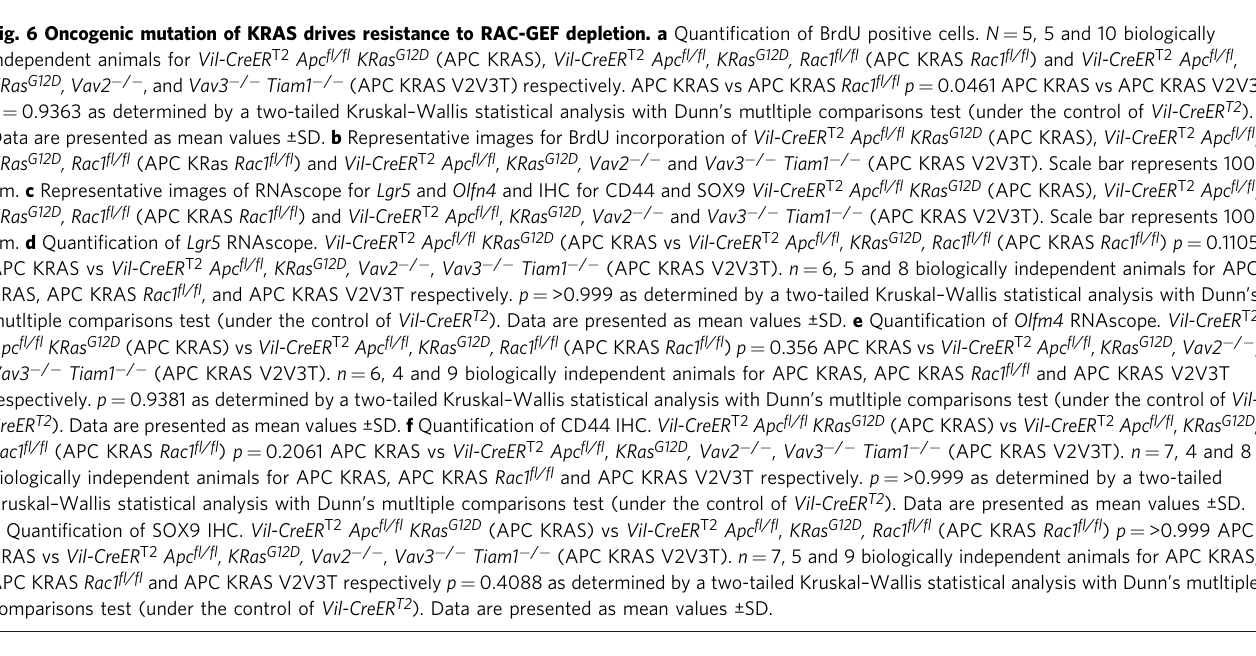
Fig. 6 Oncogenic mutation of KRAS drives resistance to RAC-GEF depletion. a Quanti fi cation of BrdU positive cells. N = 5, 5 and 10 biologically independent animals for Vil-CreER T2 Apc fl /fl KRas G12D (APC KRAS), Vil-CreER T2 Apc fl / fl , KRas G12D , Rac1 fl / fl (APC KRAS Rac1 fl / fl ) and Vil-CreER T2 Apc fl /fl , KRas G12D , Vav2 − / − , and Vav3 − / − Tiam1 − / − (APC KRAS V2V3T) respectively. APC KRAS vs APC KRAS Rac1 fl / fl p = 0.0461 APC KRAS vs APC KRAS V2V3 p = 0.9363 as determined by a two-tailed Kruskal – Wallis statistical analysis with Dunn ’ s mutltiple comparisons test (under the control of Vil-CreER T2